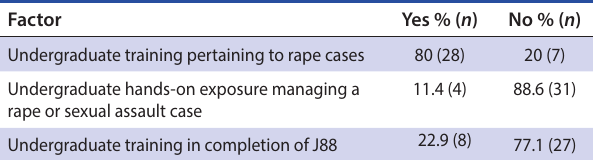
Table 6: Undergraduate training for management of patient who reported being raped or sexually assaulted ( n = 35)